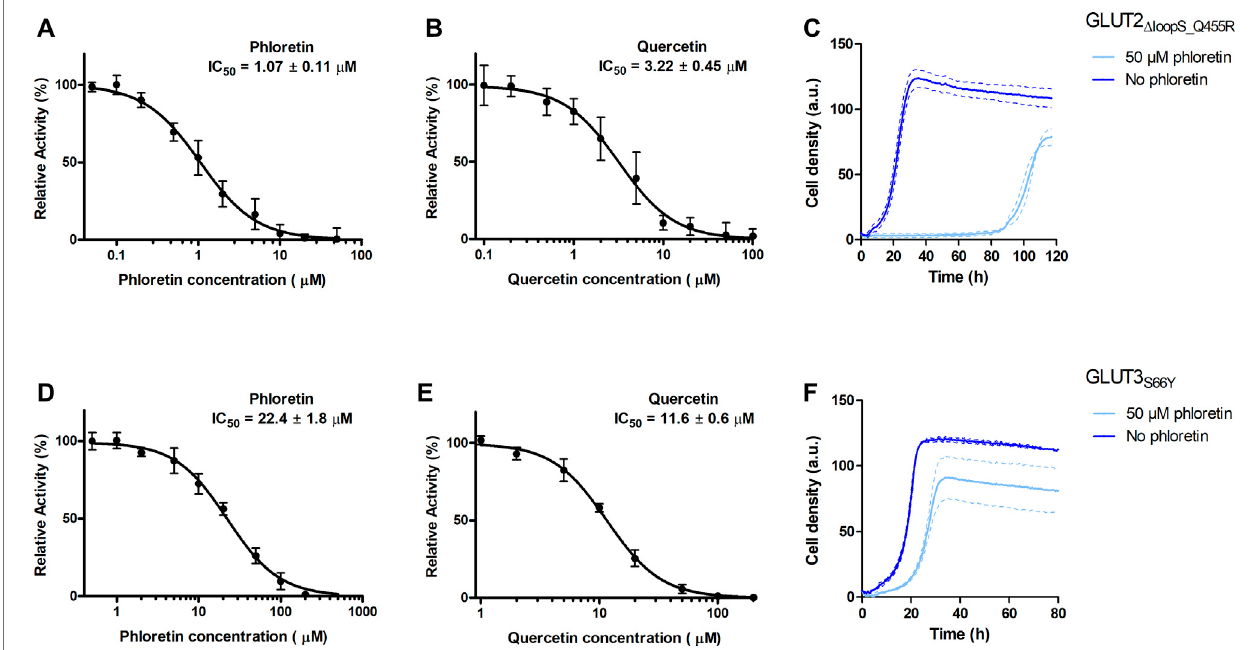
FIGURE5| Effect ofphloretin and quercetin on GLUT2 Δ loopS_Q455R and GLUT3 S66Y expressed inhxt 0 EBY.S7 cells. The relative transport activity (expressed as% of the transport in the absence of the inhibitor) of GLUT2 Δ loopS_Q455R (A,B) and GLUT3 S66Y (D,E) as a function of phloretin (A,D) or quercetin (B,E) concentrations at 10 mM (for GLUT2 Δ loopS_Q455R , (A,B) ) or 1 mM (for GLUT3 S66Y , (D,E) ) glucose is shown. Error bars represent the standard deviation from three independent measurements.GrowthassayswithGLUT2 Δ loopS_Q455R (C) orGLUT3 S66Y (F) expressingEBY.S7cellsonYEPmediumsupplementedwith0.2%(w/v)glucoseand G418 (200 μ g/ml) in the presence of 50 μ M phloretin (light blue) or its absence (dark blue) were recorded with the Cell Growth Quanti fi er (Aquila Biolabs). The average of two biological replicates (continuous lines) and the error (dashed lines) are shown. Apparent maximal growth rates of the here-depicted experiments, and EBY.S7 cells expressing Hxt1 with and without phloretin as a control, were calculated with the CGQuant software and are listed together with the duration of lag phases in Supplementary Table S6